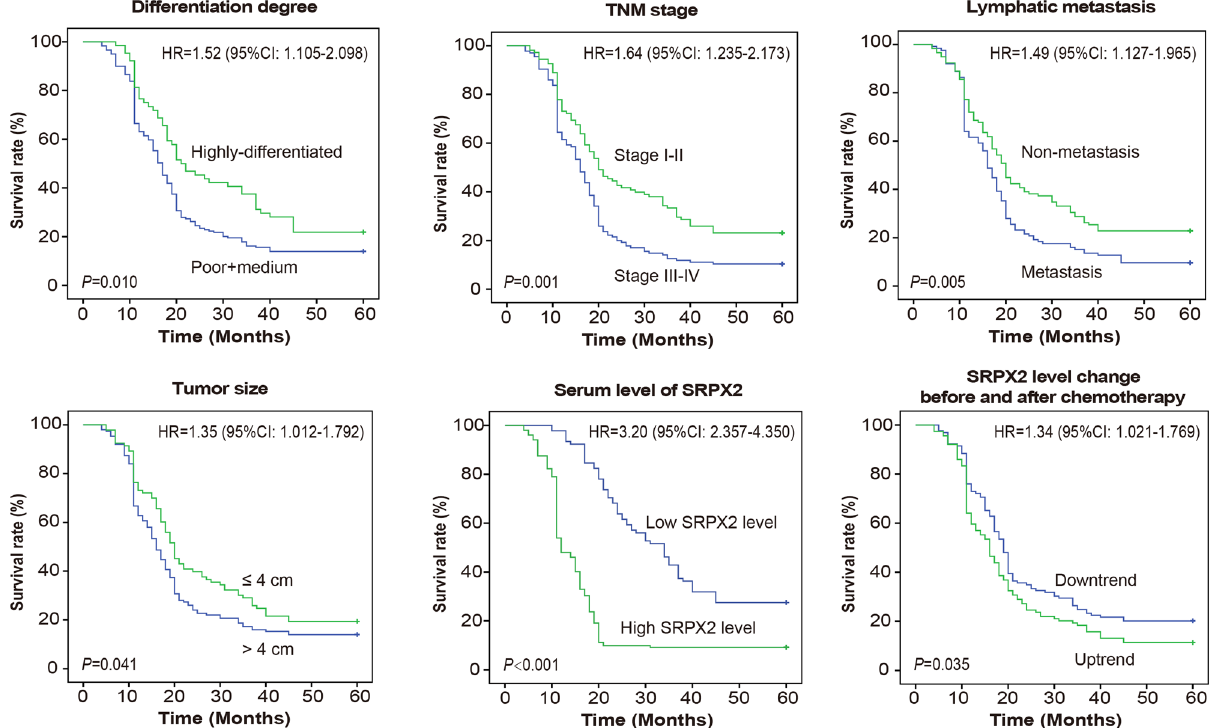
Figure 2: Prognosis of PC patients were compared when they were grouped according to di ff erentiation level, TNM stage, lymphatic metastasis condition, tumor size, basal SRPX2 level and SRPX2 level change before and after chemotherapy. PC: pancreatic